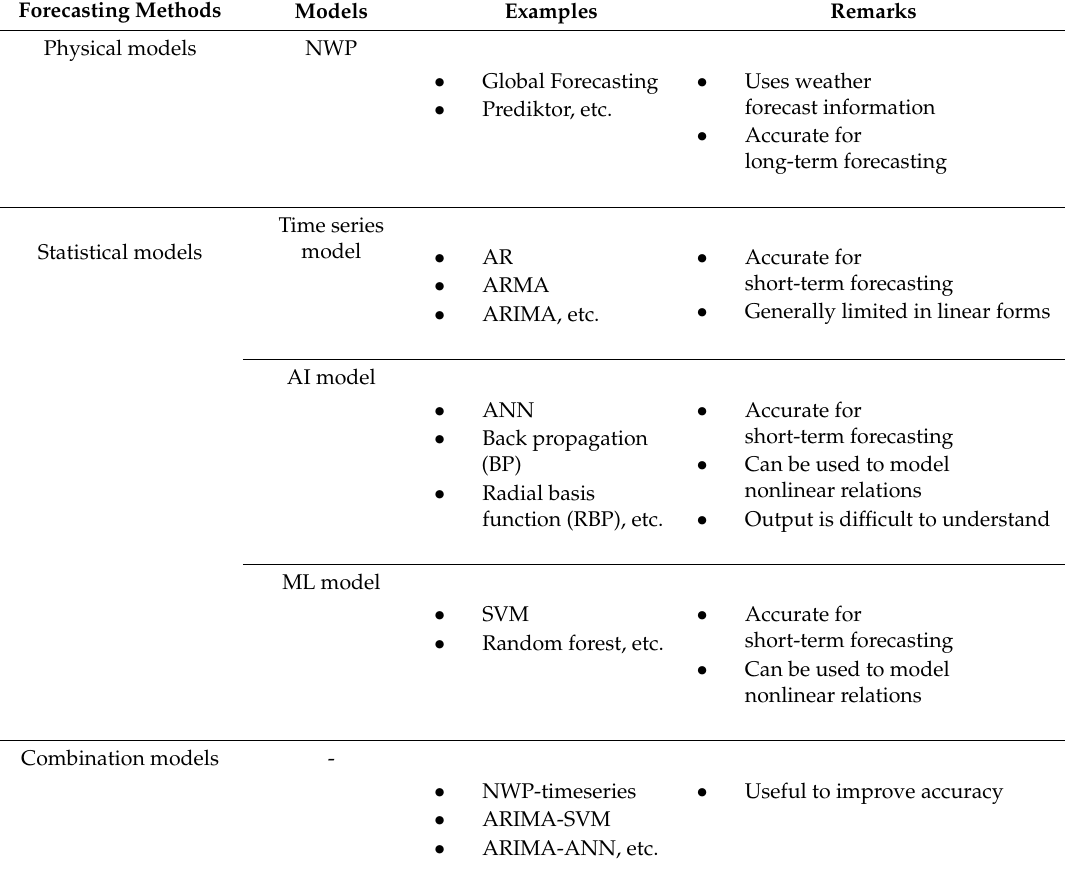
Table 1. Classification of wind power forecasting